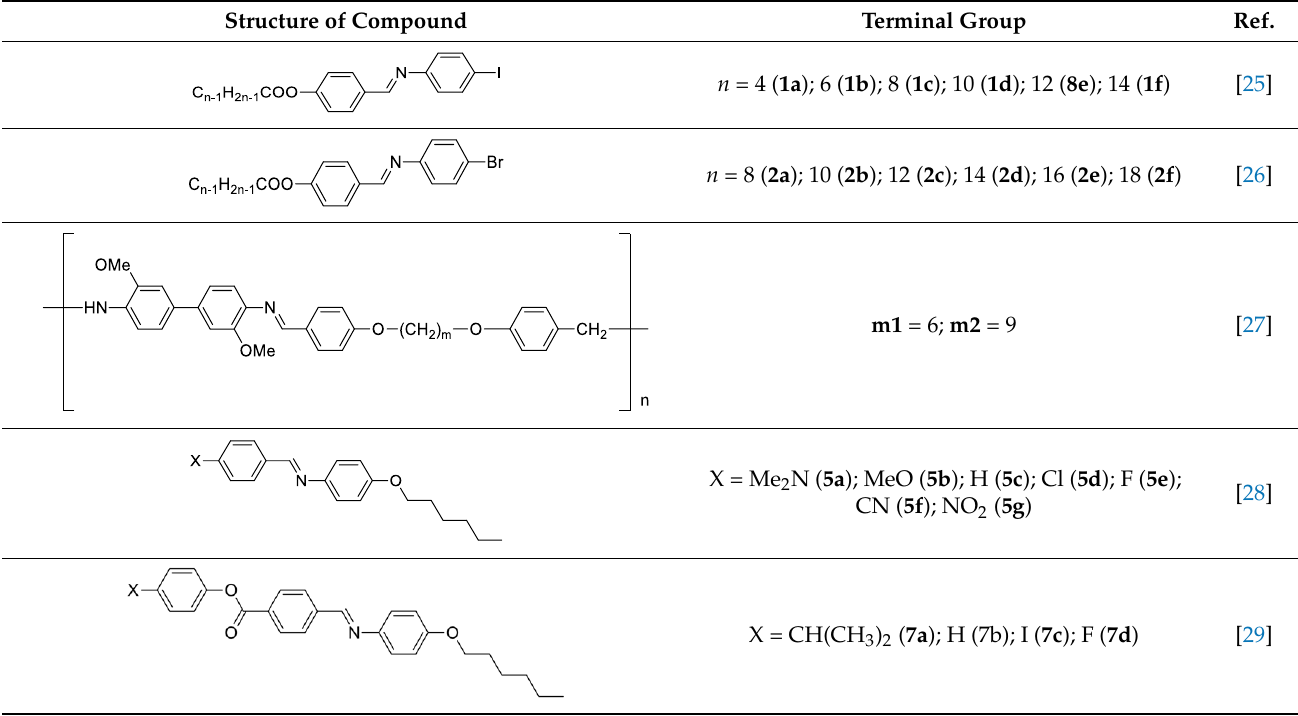
Table 2. Phase transition temperatures of compound 1(a-f) . Reprinted/adapted with permission from Ref. [25]; published by Elsevier, 2011.